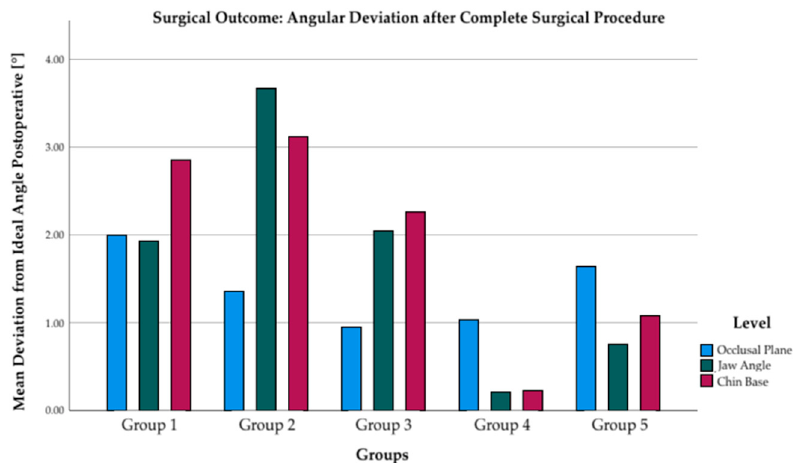
Figure 15. Angular deviation from ideal angle to midfacial plane (90°) after complete surgical treat- ment.